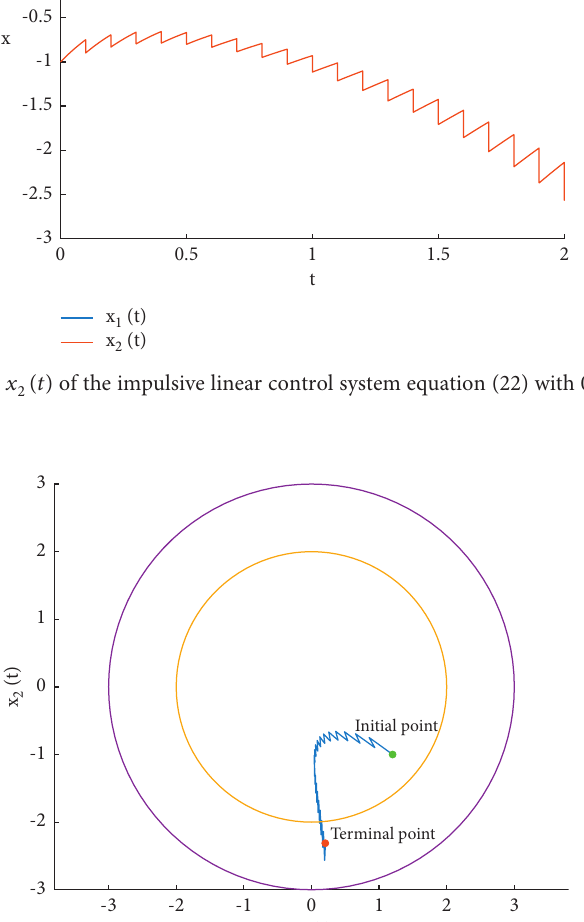
Figure 4: Phase portrait of the impulsive linear control system equation (22) with 0 . 1s equidistant impulsive